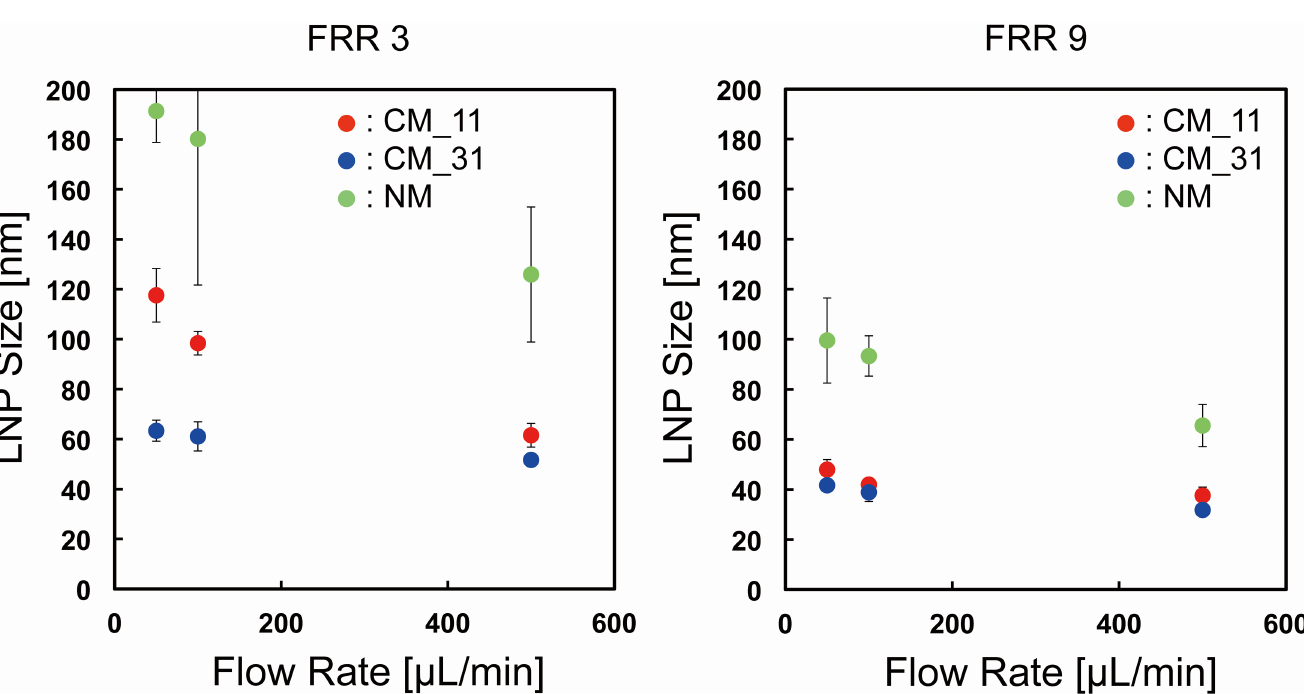
Fig 5. The effect of mixer structureson the LNP size at different flow conditions. The error bars represent the standard deviationcalculatedfrom repeatingeach LNP formation experiment at least three times.